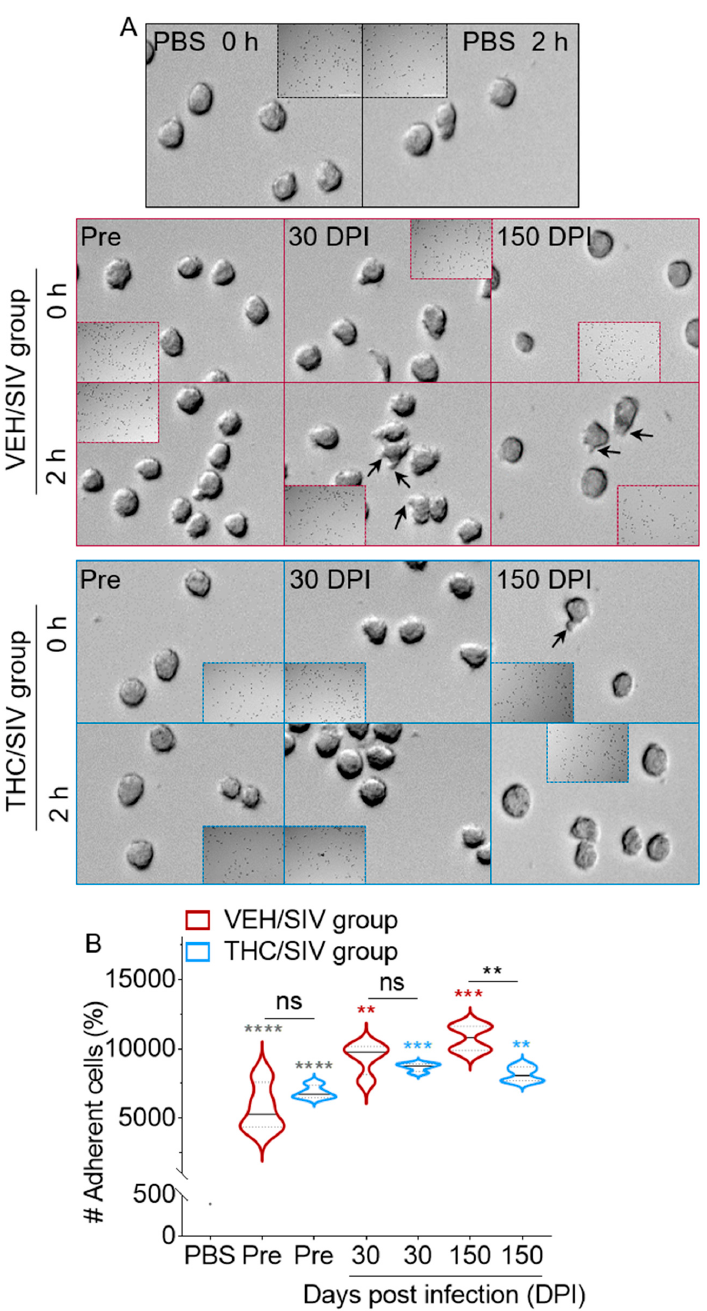
Figure 5. U937 spreading and adhesion to type I collagen are inhibited by THC/SIV BEVs: ( A ) representative images of U937 cell spreading on type I collagen following treatment with BEVs at 1000 μ g/mL. The 10× magnification kinetic images were acquired at t = 0 h and t = 2 h using the Lionheart FX automated microscope. Black arrows indicate membrane protrusions. Scale bar: 50 µ m. ( B ) Quantification of adherent monocytes incubated with 1000 μ g/mL BEVs for 18 h. Full view of each well was analyzed. Ordinary one ‐ way ANOVA (Brown–Forsythe and Bartlett tests, with Sidak’s multiple comparisons test) was used to determine the statistical significance within the group. Binary Student’s t tests (Welch’s correction) were used to determine significant differences between groups for each of the time points in each group. ** p < 0.01, *** p < 0.005, **** p < 0.001, and ns = non ‐ significant.